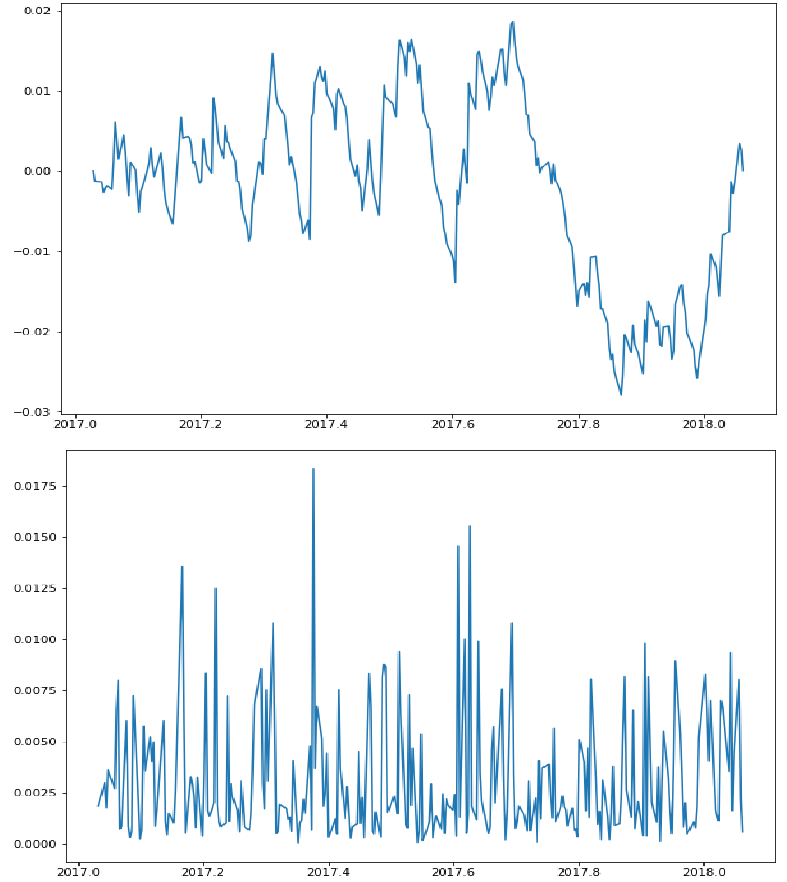
Figure 3. The plot at the top illustrates the volatility series of the S&P500 index in the period ranging from January 2017 to January 2018, whereas the graph at the bottom depicts the series of absolute values of the log-returns of the S&P500 index in the same period. In this case, the self-similarity exponent of the volatility series was found to be equal to 0.55 by the FD4